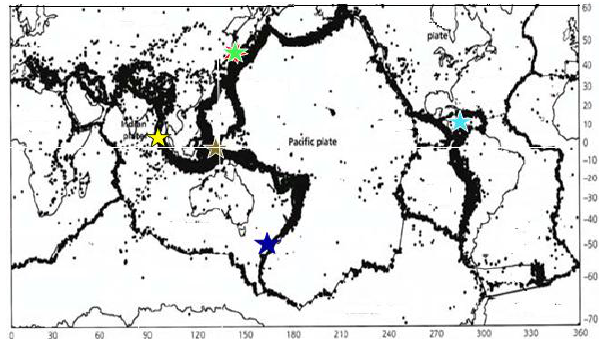
Fig. 1. Map with the position of the epicentre of the 6 great ( M = 6.8) earthquakes in the month preceding the Sumatra 2004 earthquake. The earthquakes were located at the edge of Pacific Figure 1 Plate. . .